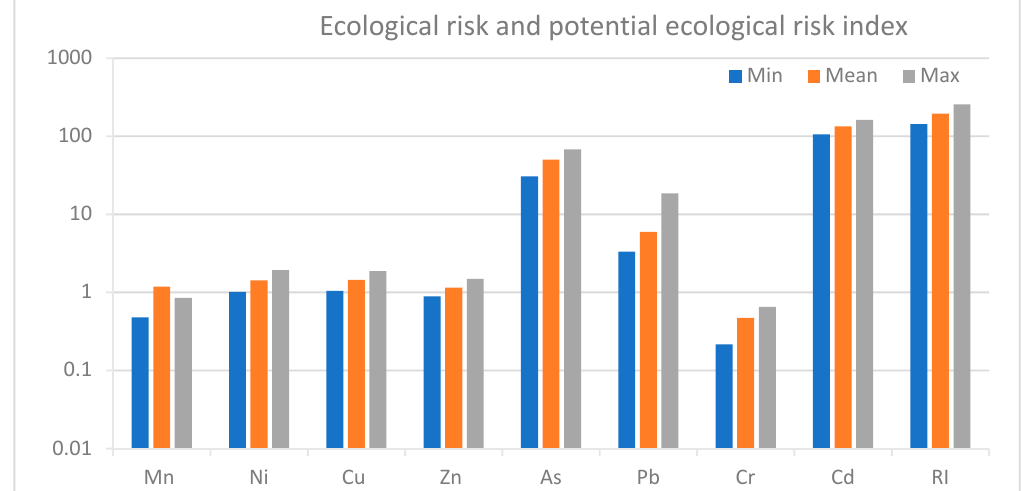
Figure 3. Risk assessment for urban soils using the enrichment factor, geoaccumulation factor, contamination factor, ecological risk and potential ecological risk index.